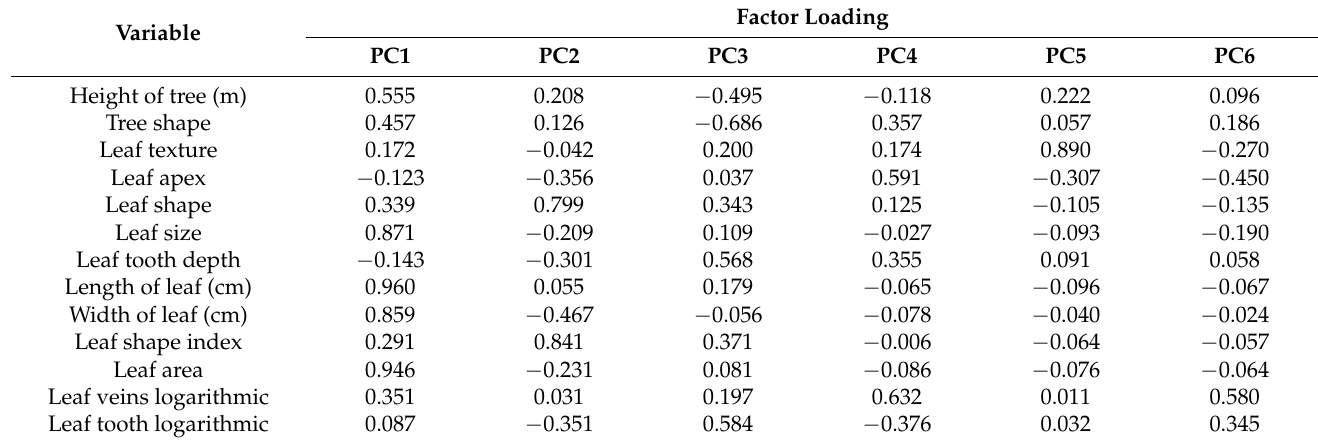
Table 2. Principal component scores of each phenotypic characters measured of 145 samples of ancient tea plant germplasm.